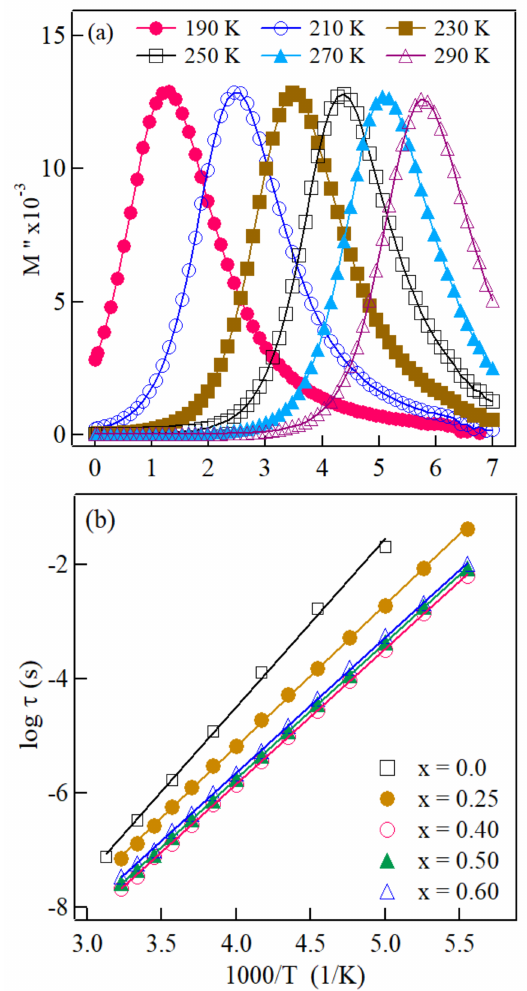
Figure 7. ( a ) The frequency dependence of the electric modulus at selected temperatures for Li 5.5 La 3 Nb 1.75 Sm 0.25 O 12 ceramics as a representative sample; ( b ) the temperature dependence of the relaxation time determined from the electric modulus spectra of Li 5+2x La 3 Nb 2 − x Sm x O 12